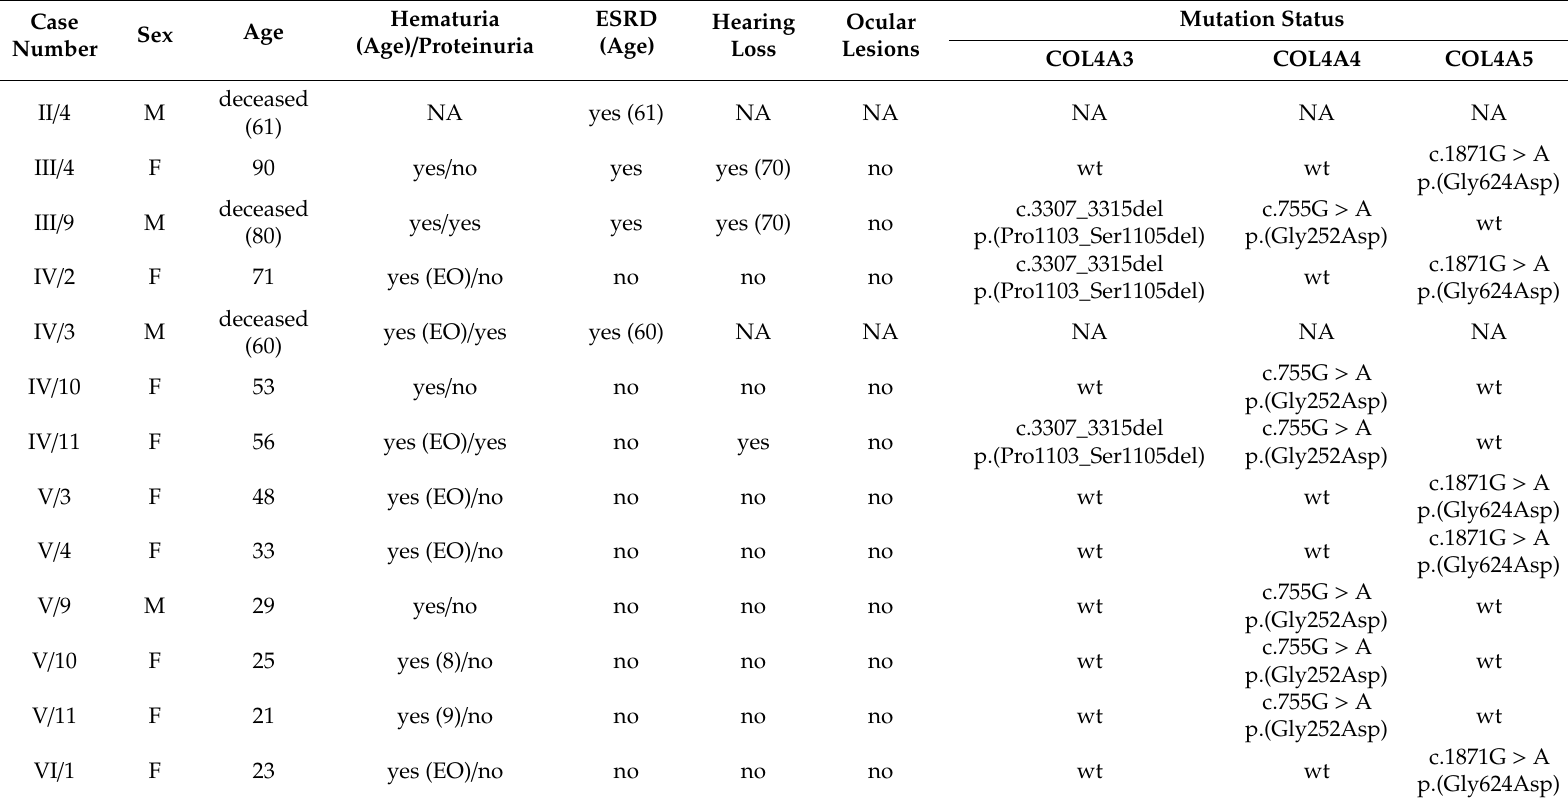
Table 1. Clinical characteristics and corresponding mutations in the Galiˇcnik